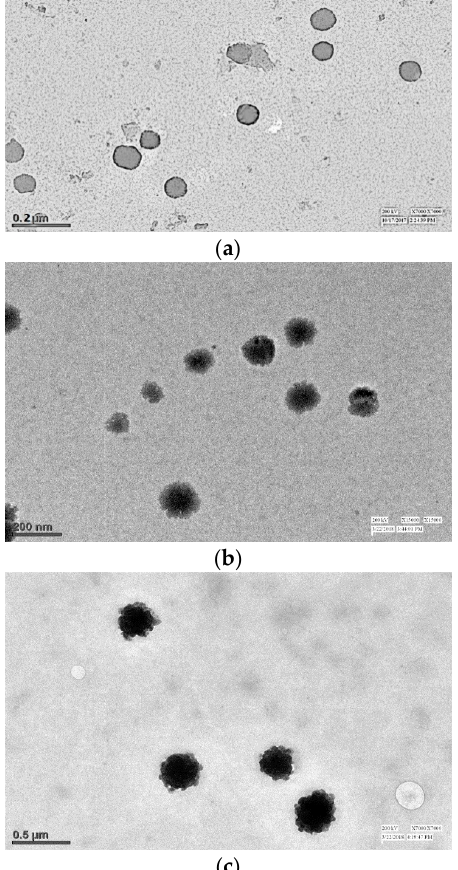
Figure 8. Transmission Electron Microscopy (TEM) images of ( a ) Blank Liposomes ( b ) Dacarbazine and Eugenol Liposomes ( c ) Dual loaded surface-functionalized liposomes. ( a ) Liposomes appear hollow with thin lipid bimembrane ( b ) Liposomes have darker core and thickened lipid bimembrane indicating towards loading of both drugs ( c ) Liposomes have irregular surface indicating surface coating.